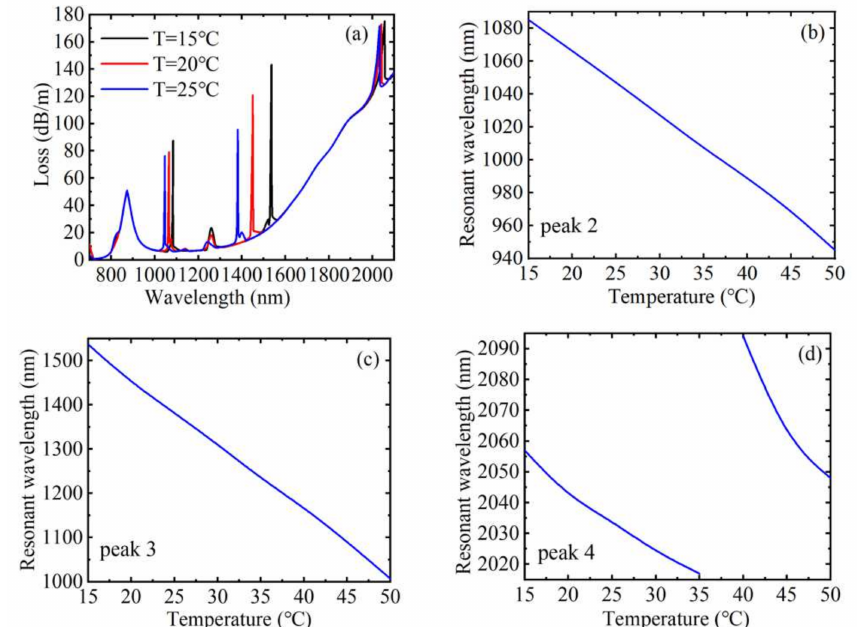
Figure 6. ( a ) The loss spectrum of the core guide mode with three different temperatures when n = 1.41, H = 250 Oe, and V = 30 V. The variation relationship between the resonant wavelength corresponding to different peaks and temperature: ( b ) peak 2, ( c ) peak 3, and ( d ) peak